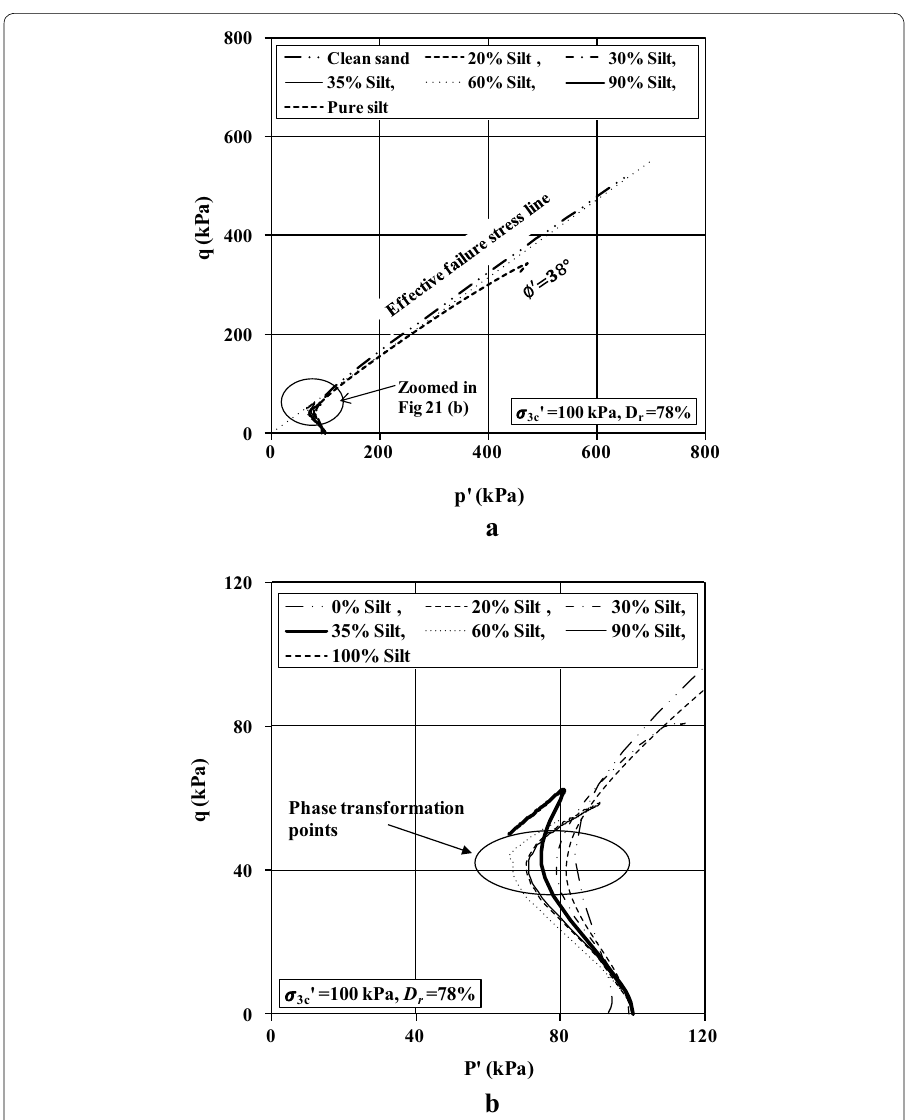
Fig. 21 Effective stress path of tested specimens at 78% initial relative density; a silt content 0–100% and b phase transformation